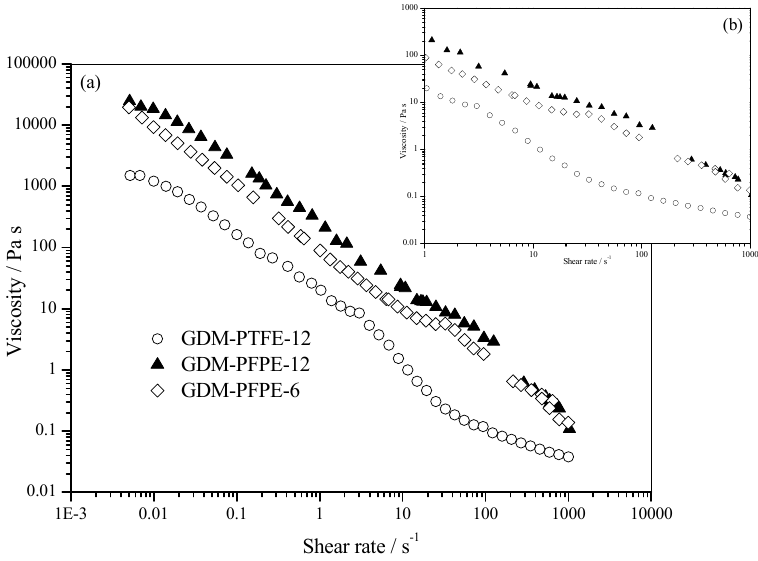
Figure 1. ( a ) Results of rheological analysis of the prepared inks; ( b ) Focus of the shear rate range 1–1000 s − 1